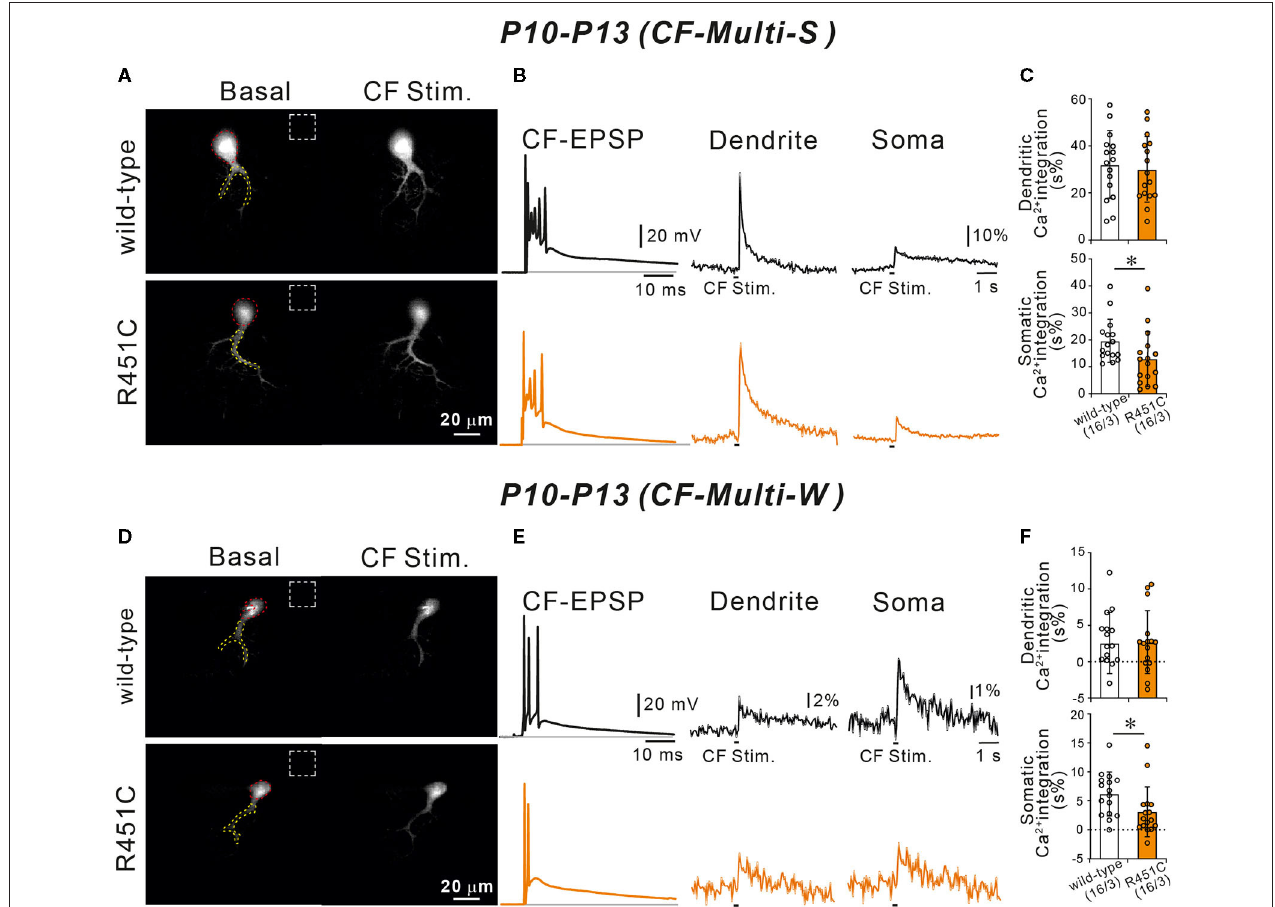
FIGURE 7 | Ca 2 + transients induced by strong and weak CF inputs are smaller in NLGN3-R451C mutant mice than in wild-type mice. (A) Representative images of a wild-type (upper left) and a NLGN3-R451C mutant (lower left) PC. Areas demarcated by red and yellow dotted lines represent ROIs for somatic and dendritic Ca 2 + transients, respectively. Dashed rectangles represent the ROIs where the background fluorescence signals were measured. Scale bar, 20 µ m. (B) Representative traces of CF-induced EPSP (right) and those of Ca 2 + transients recorded in the dendrite (middle) and the soma (right) of multiply-innervated PCs in response to stimulation of the strongest CF in wild-type (black) and NLGN3-R451C mutant (orange) mice. Scale bars, 20mV and 10ms for CF-EPSC, 10% and 1s for Ca 2 + transients. (C) Average magnitudes of Ca 2 + transients from the soma and the dendrite by stimulating the strongest CF in wild-type (open columns) and NLGN3-R451C mutant (orange columns) mice. p = 0.77 (Dendrite) and * p = 0.026 (Soma) by Mann-Whitney U test. (D) Representative images of a wild-type (upper left) and a NLGN3-R451C mutant (lower left) PC shown similarly to (A) . Scale bar, 20 µ m. (E,F) Representative traces (E) and average magnitudes of Ca 2 + transients (F) shown similarly to (A,B) , respectively, but for responses to stimulation of a weak CF of a multiply innervated PC. Scale bars, 20mV and 10ms for CF-EPSC, 2% or 1% and 1s for Ca 2 + transients. p = 0.86 (Dendrite) and * p = 0.015 (Soma) by Mann-Whitney U test. Data for (A–F) were obtained from P10 to P13 mice. Data in (C,F) are expressed as mean ± SD. Numbers of PCs/mice are shown in